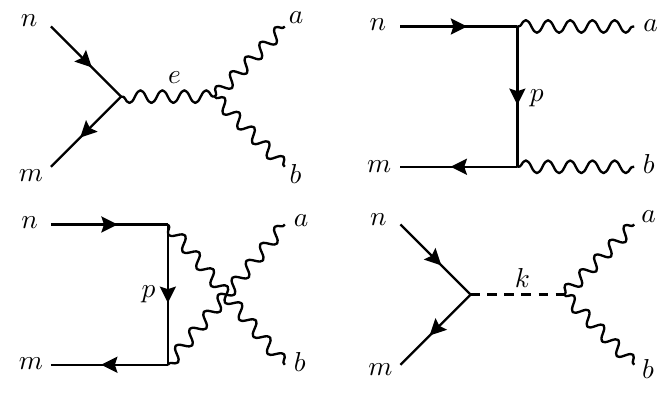
Figure 1 . Diagrams for the scattering f n + f